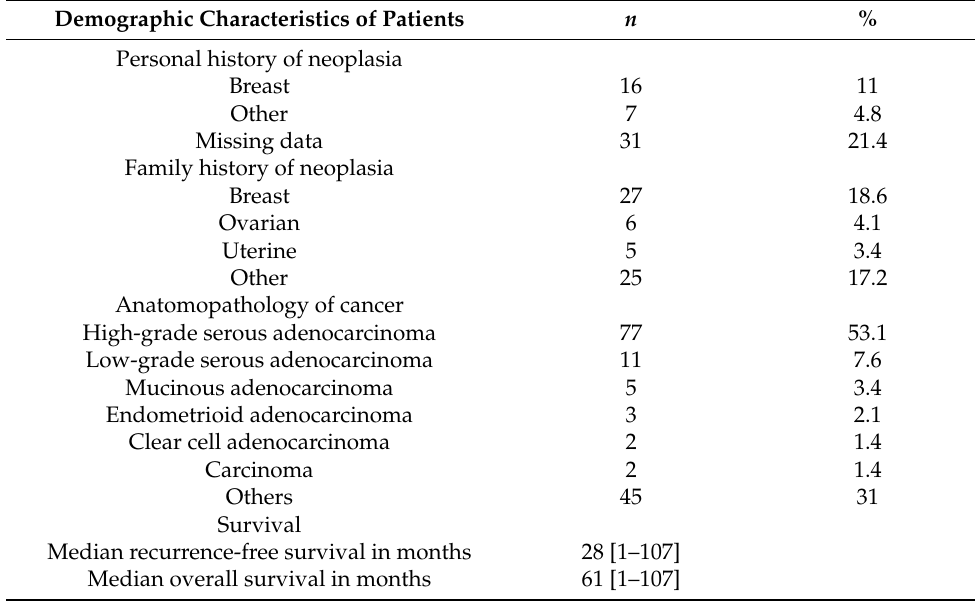
Table 1. Key demographic characteristics of patients ( n =